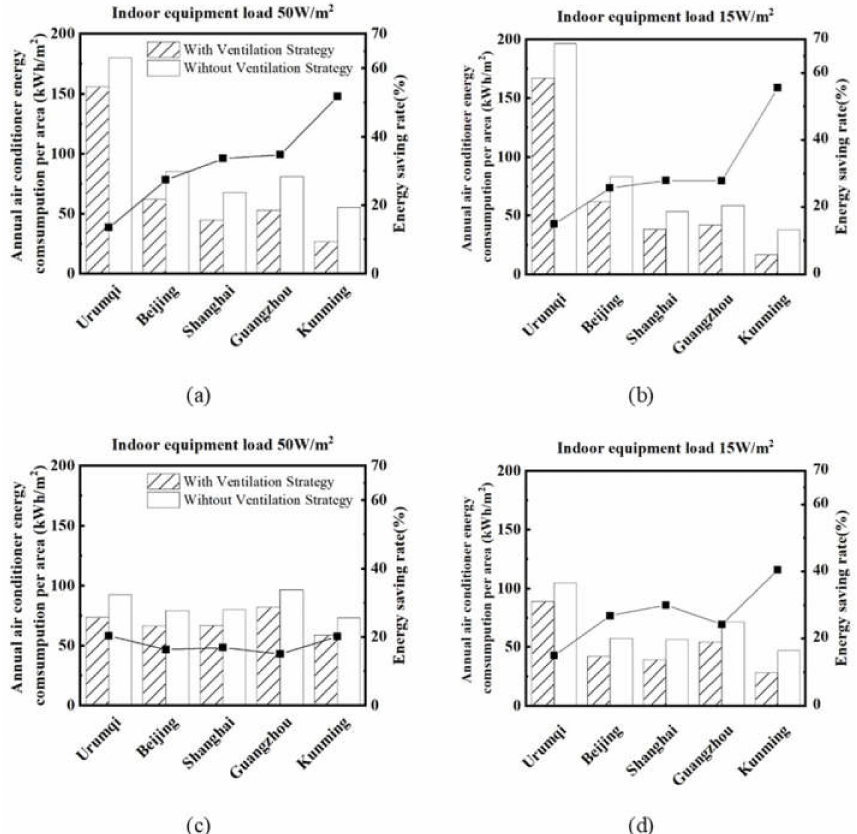
Figure 7. Annual energy consumption per area of air conditioning and energy-saving rate in different climate zones with and without rule-based control strategy: ( a ) indoor equipment load of 50 W/m 2 with the envelope exposed to outdoor environment; ( b ) indoor equipment load of 15 W/m 2 with the envelope exposed to outdoor environment; ( c ) indoor equipment load of 50 W/m 2 with the envelope defined as adiabatic; ( d ) indoor equipment load of 15 W/m 2 with the envelope defined as